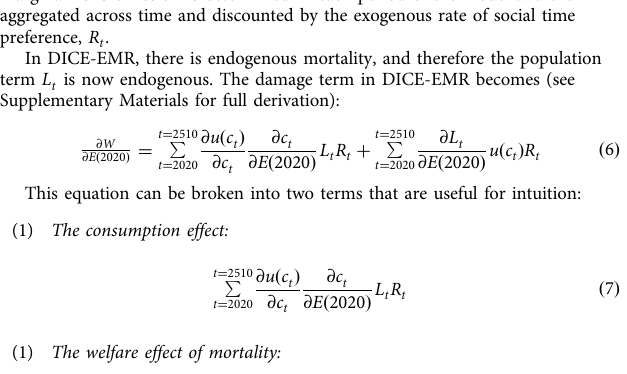
; β } are the estimated coef fi cients, and δ ð T t Þ is the % increase in the 1 2